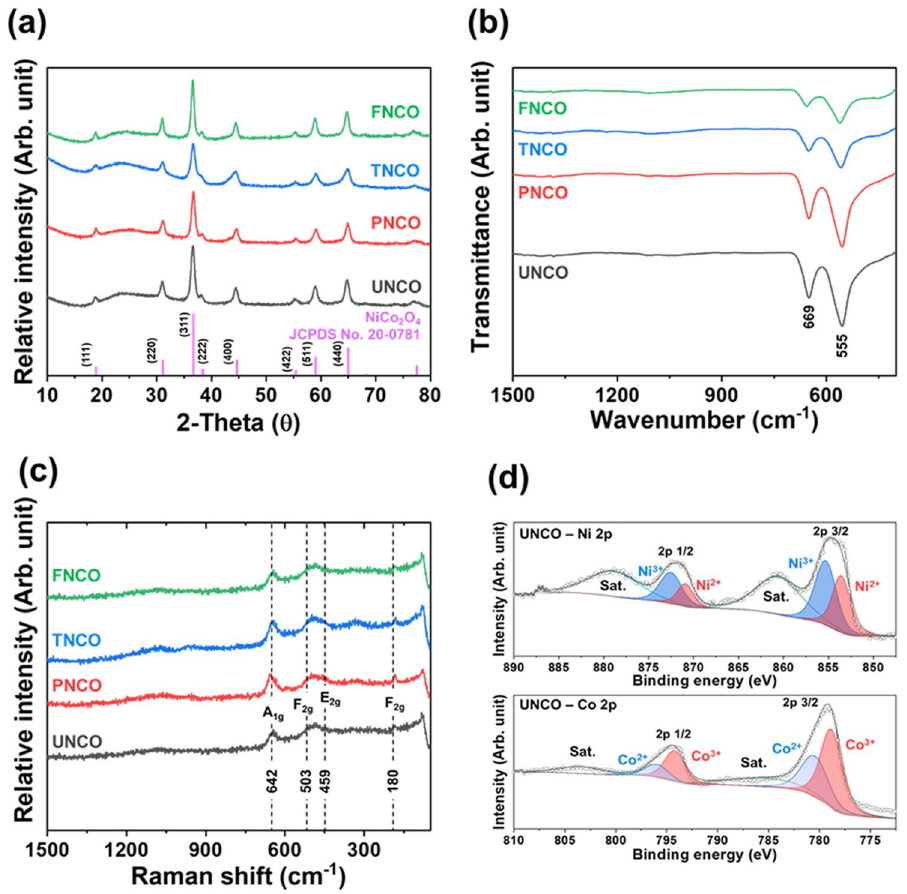
Figure 3. ( a ) XRD patterns, ( b ) FT-IR spectra, and ( c ) Raman spectra of the NCO nanomaterials; ( d ) XPS spectra of Ni 2p and Co 2p of